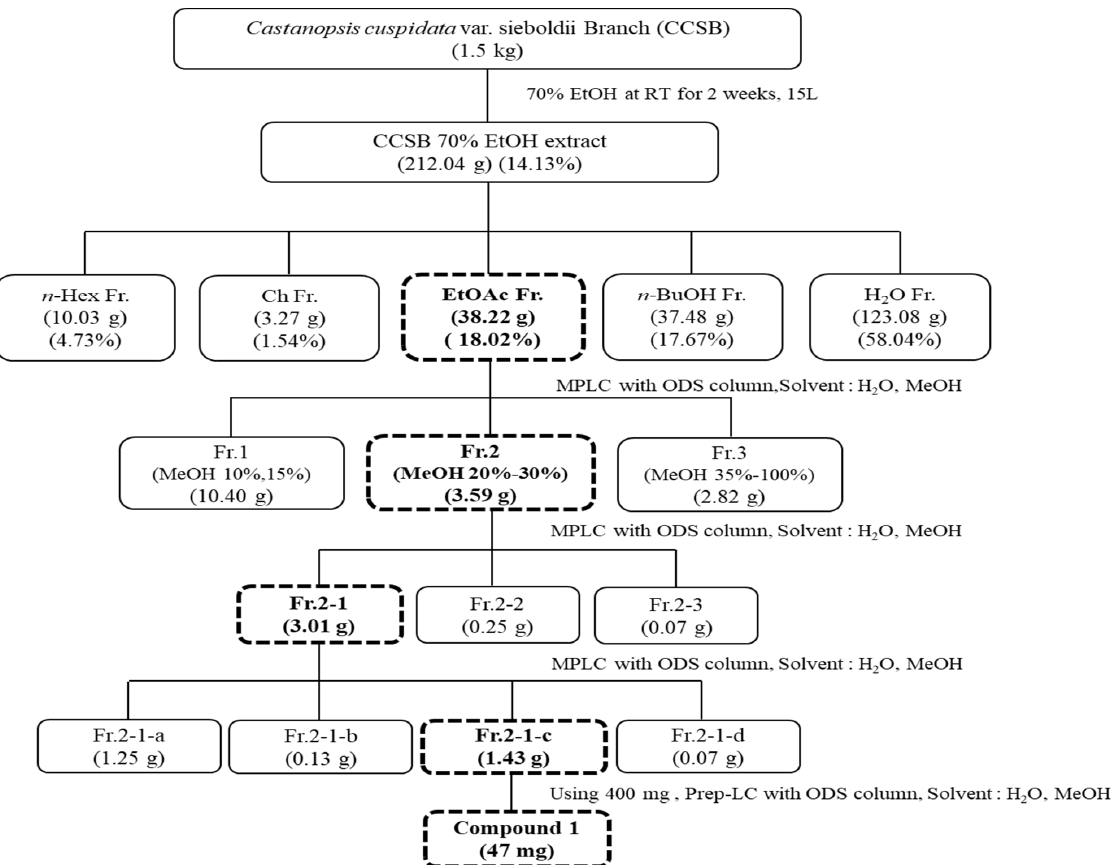
Figure 1. Isolation diagram of C. cuspidata var. sieboldii branch EtOAc fraction and subfraction. n